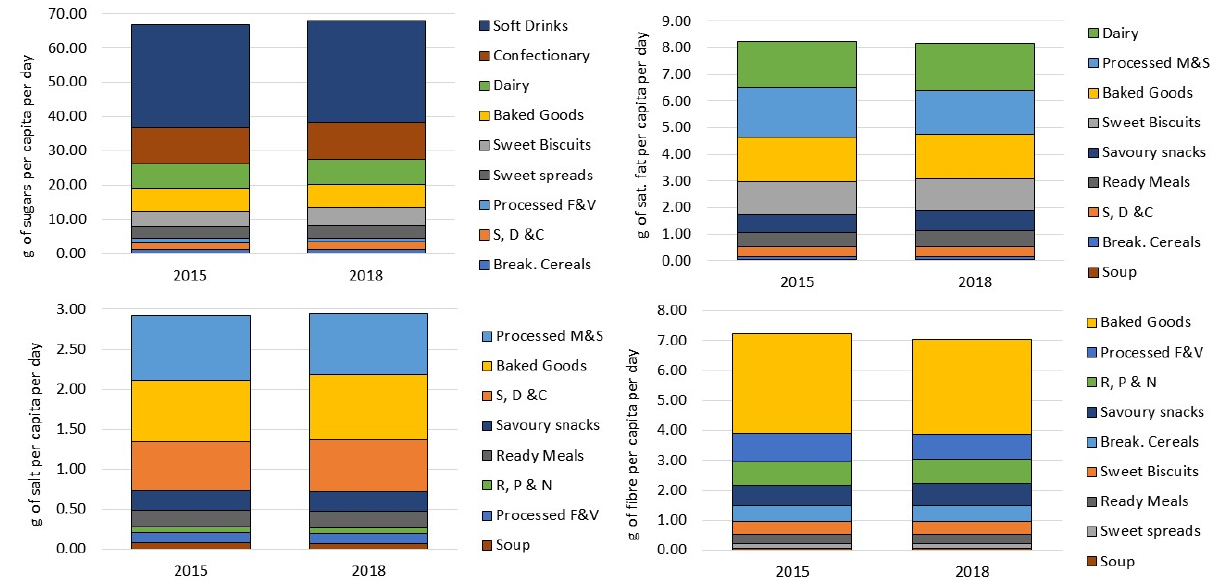
Figure 1. Sales of total sugars, saturated fat, salt and fibre (in g per capita per day) of packaged foods and soft drinks categories in Europe (2015–2018). Source: Elaborated by the authors based on data from Euromonitor (2020) and mid-year population estimates from the HFA-DB. Estimates were scaled by market coverage to represent 100% of the retail market.